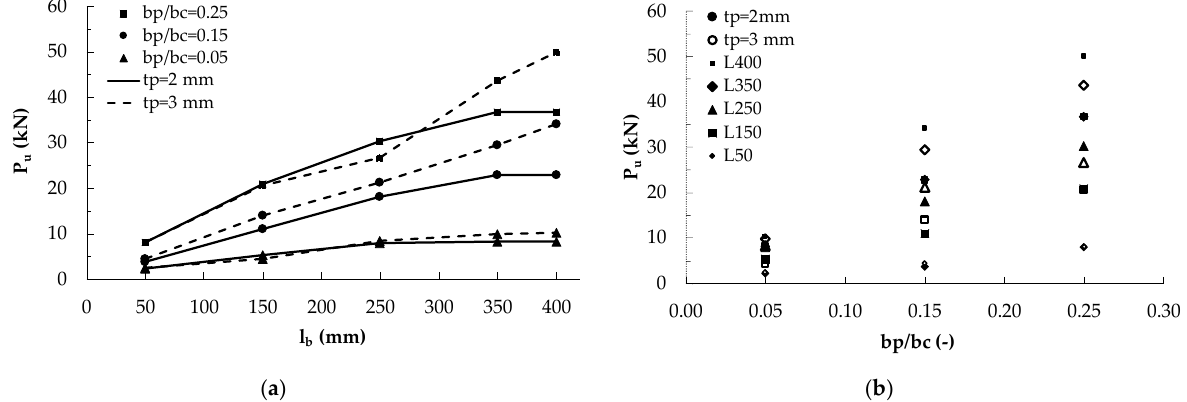
Figure 10. ( a ) Numerical debonding loads vs. bonded length for different values of b p /b c and t p ; ( b ) Numerical debonding loads vs. plate-to-concrete width ratio for different values of l b and t p .